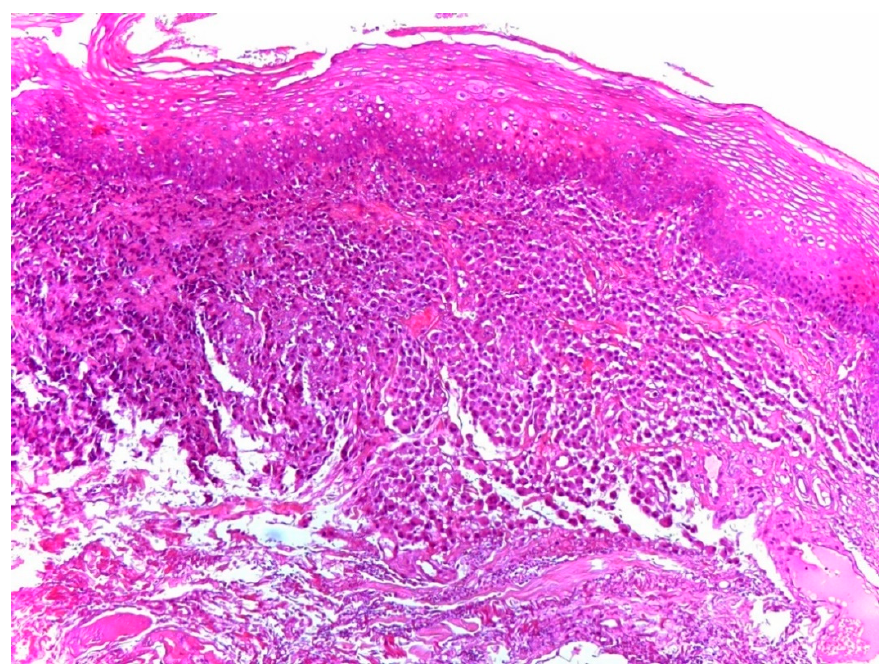
Figure 3. Monomorphic mature plasma cell chorion infiltration (HE 100X/200X) .